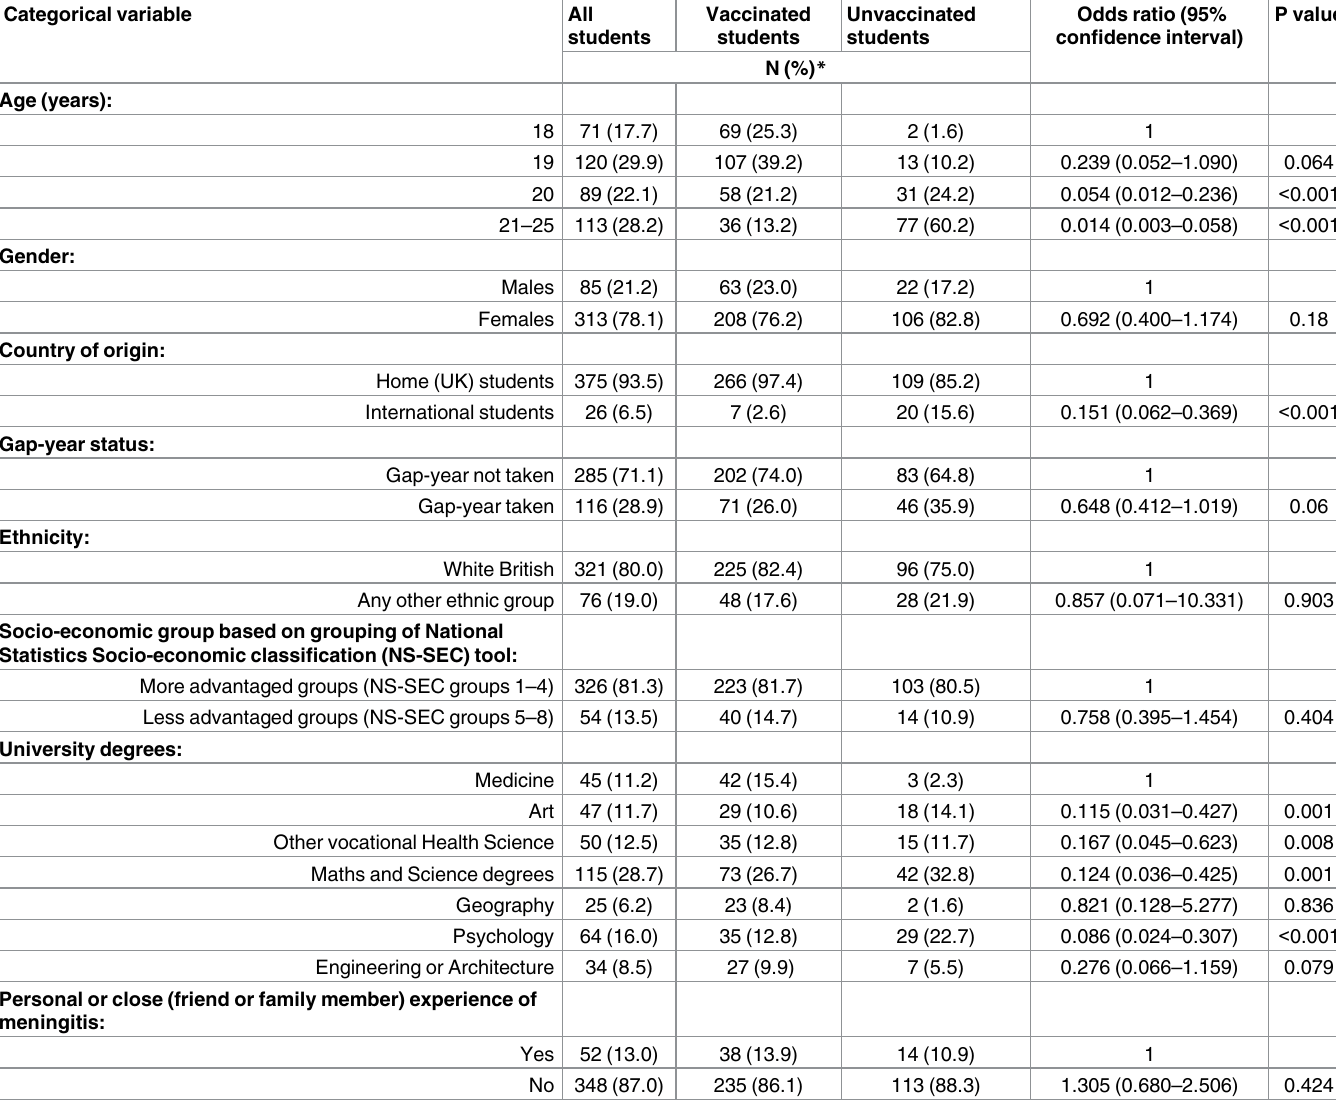
Table 2. Demographic characteristics of study participants and results of univariable regression analysis of associations between demographic variables and vaccination. Categorical